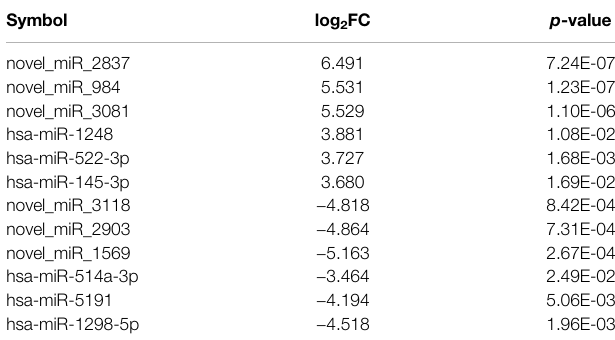
TABLE 6 | DEMs whose expressions are regulated when HIF1A expression was knocked out.